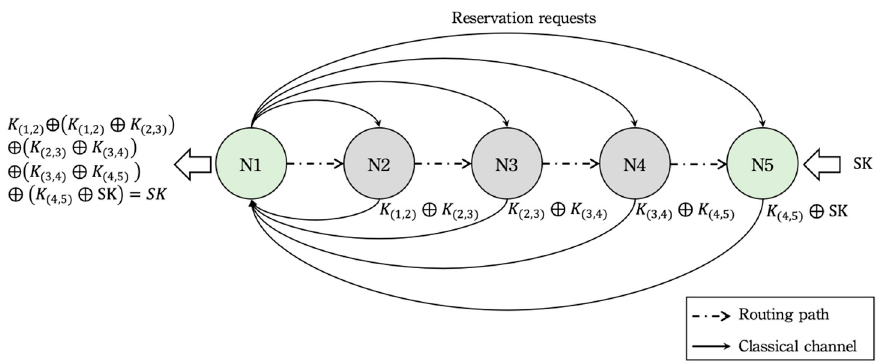
Figure 5. Session key transmission method in the DARPA QKD network.